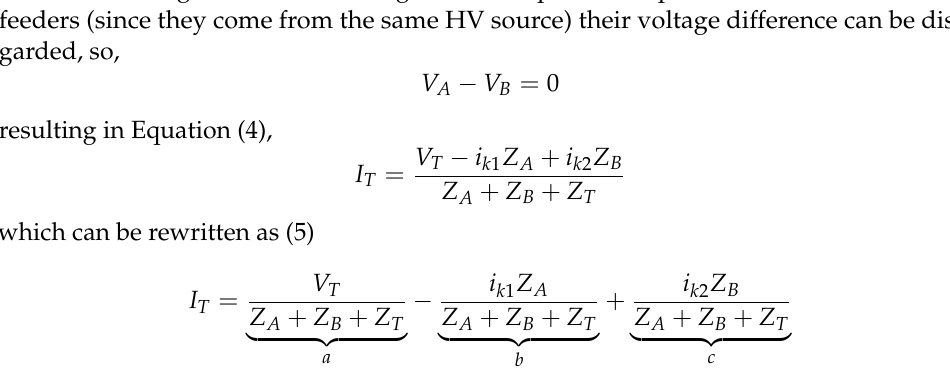
variations where the controllers should track and compensate for the voltage difference.